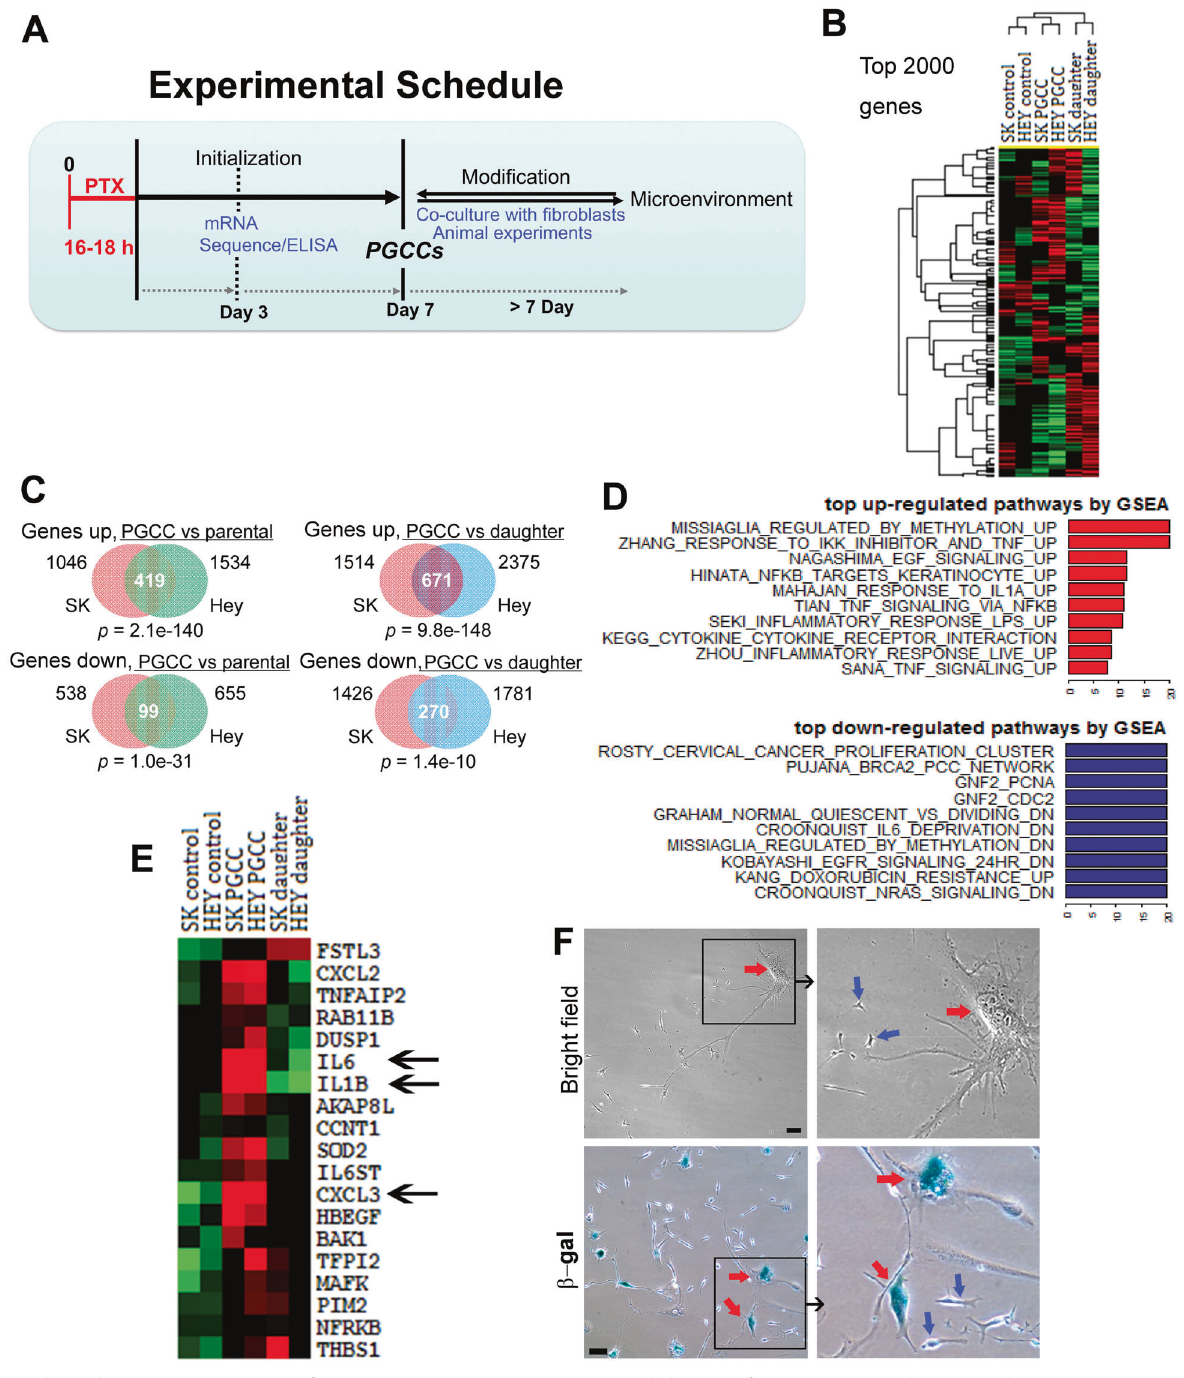
Fig. 1 Paclitaxel treatment triggers in fl ammatory response. A Experimental design. After treatment with paclitaxel (PTX; 500 nM) overnight (16-18 h), ovarian cancer cells, including the control cells without treatment and PGCCs induced by PTX were allowed to recover in their corresponding regular media. From recovery day 1 to 30, proin fl ammatory molecule levels were measured in the supernatant every 24 h. Total mRNA for sequencing was collected at recovery day 3. PGCCs collected at recovery day 7 were used for the coculture system with primary fi broblasts. B Heat map of the top 2000 genes induced by paclitaxel treatment of Hey and SKOv3 cells (control, PGCCs at recovery day 3, and daughter cells). C Up- or downregulated genes in PGCCs of Hey and SKOv3 cells (at recovery day 3) compared with the control and daughter cells. D The top up- or downregulated pathways in PGCCs compared with the control cells. E Top in fl ammatory molecules that were upregulated in PGCCs, among which IL-6 and IL-1 β , along with CXCL3, were the predominant molecules (arrows). F Representative pictures of daughter cells (blue arrows) from mother PGCCs (red arrows, at recovery day 21). PGCCs are positive for β -gal staining (lower panels, at recovery day 21), which indicates senescence. Bars, 50